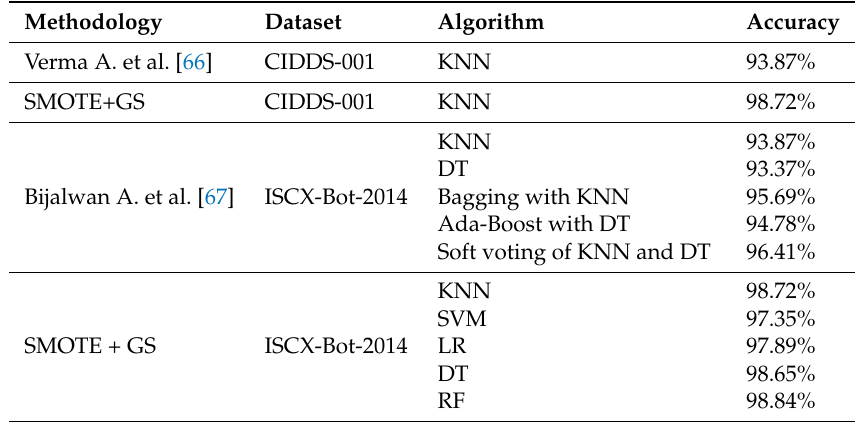
Table 10. Comparative analysis between related works for CIDDS-001 and ISCX-Bot-2014 datasets. Methodology Dataset Algorithm